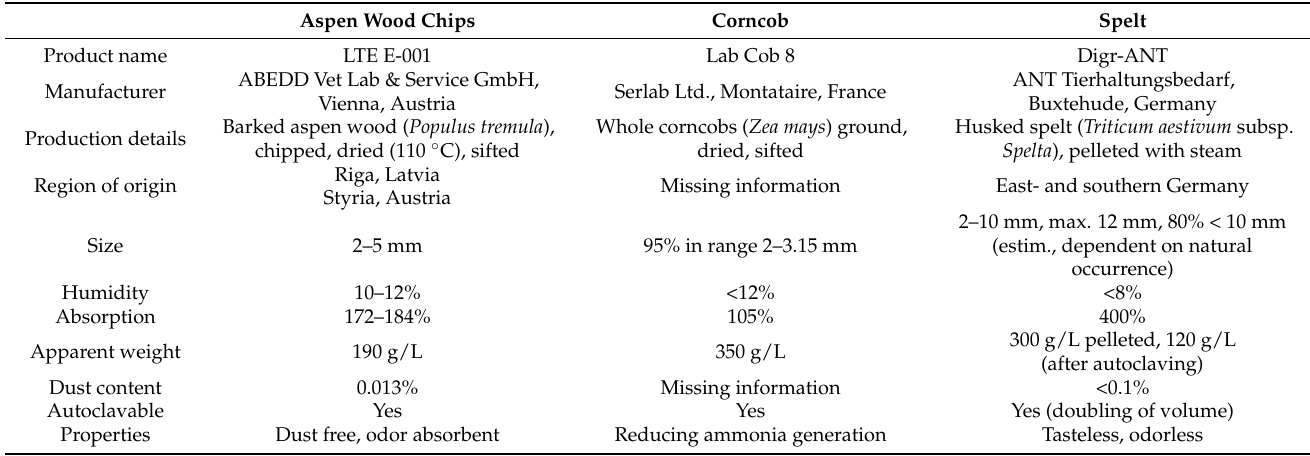
Table 1. Comparative evaluation of the three bedding substrates used in this study. The different aspects are provided by the respective